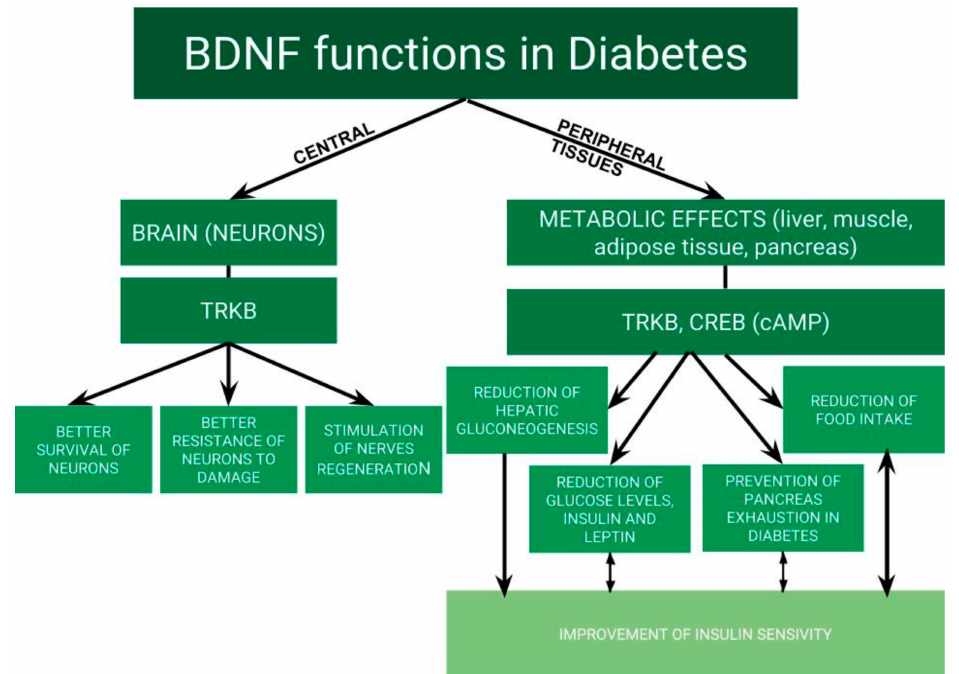
Figure 1. Functions of brain-derived neurotrophic factor (BDNF) in